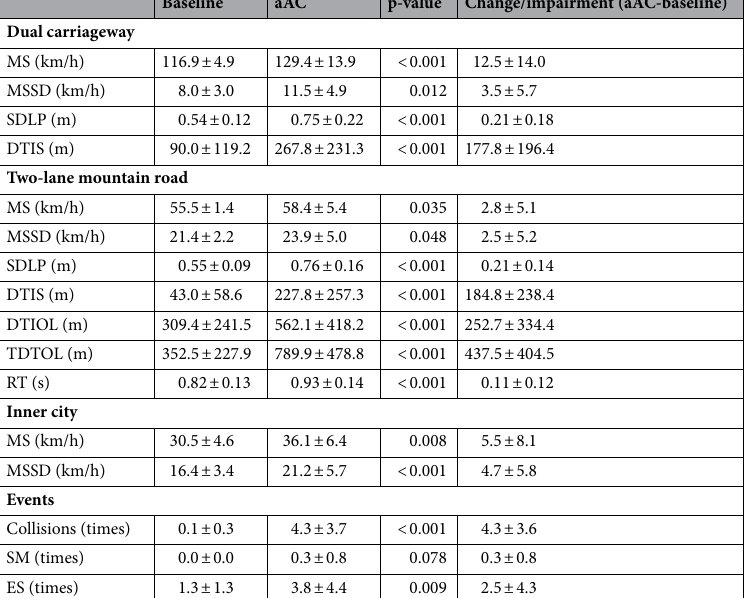
Table 4. Mean values and standard deviations for all the simulated driving parameters, measured at baseline and after alcohol consumption (aAC; BrAC = 0.40 mg/l), including the mean change for each parameter,